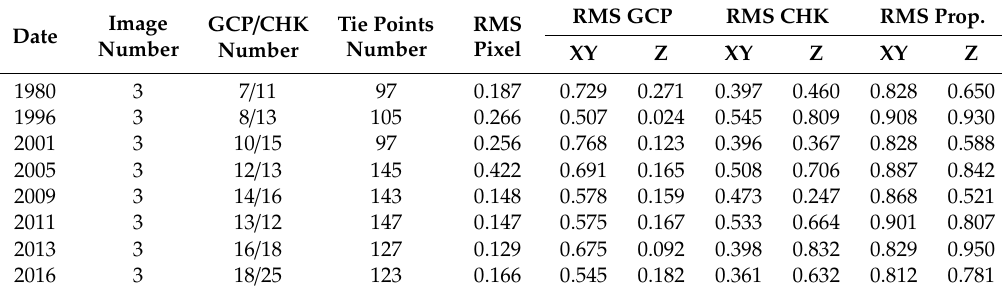
Table 3. Errors of orientation process at control (GCP) and check (CHK) points 1 .